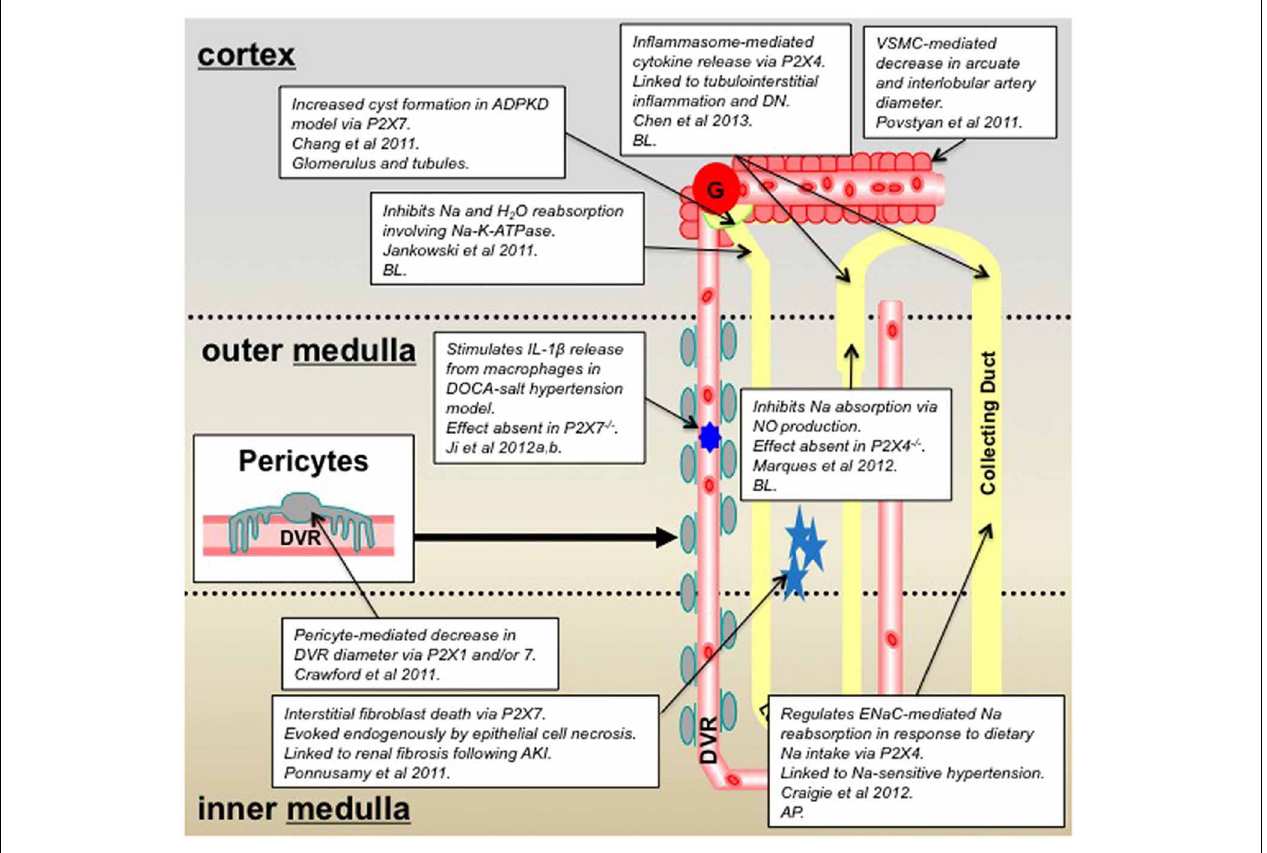
FIGURE 2 | Summary of P2X receptor-mediated effects in the kidney and epithelial cell lines derived from specific nephron segments; 2011–2013 inclusive. Key: AP , denotes that the P2X receptors are localized on the epithelial cell apical membrane;